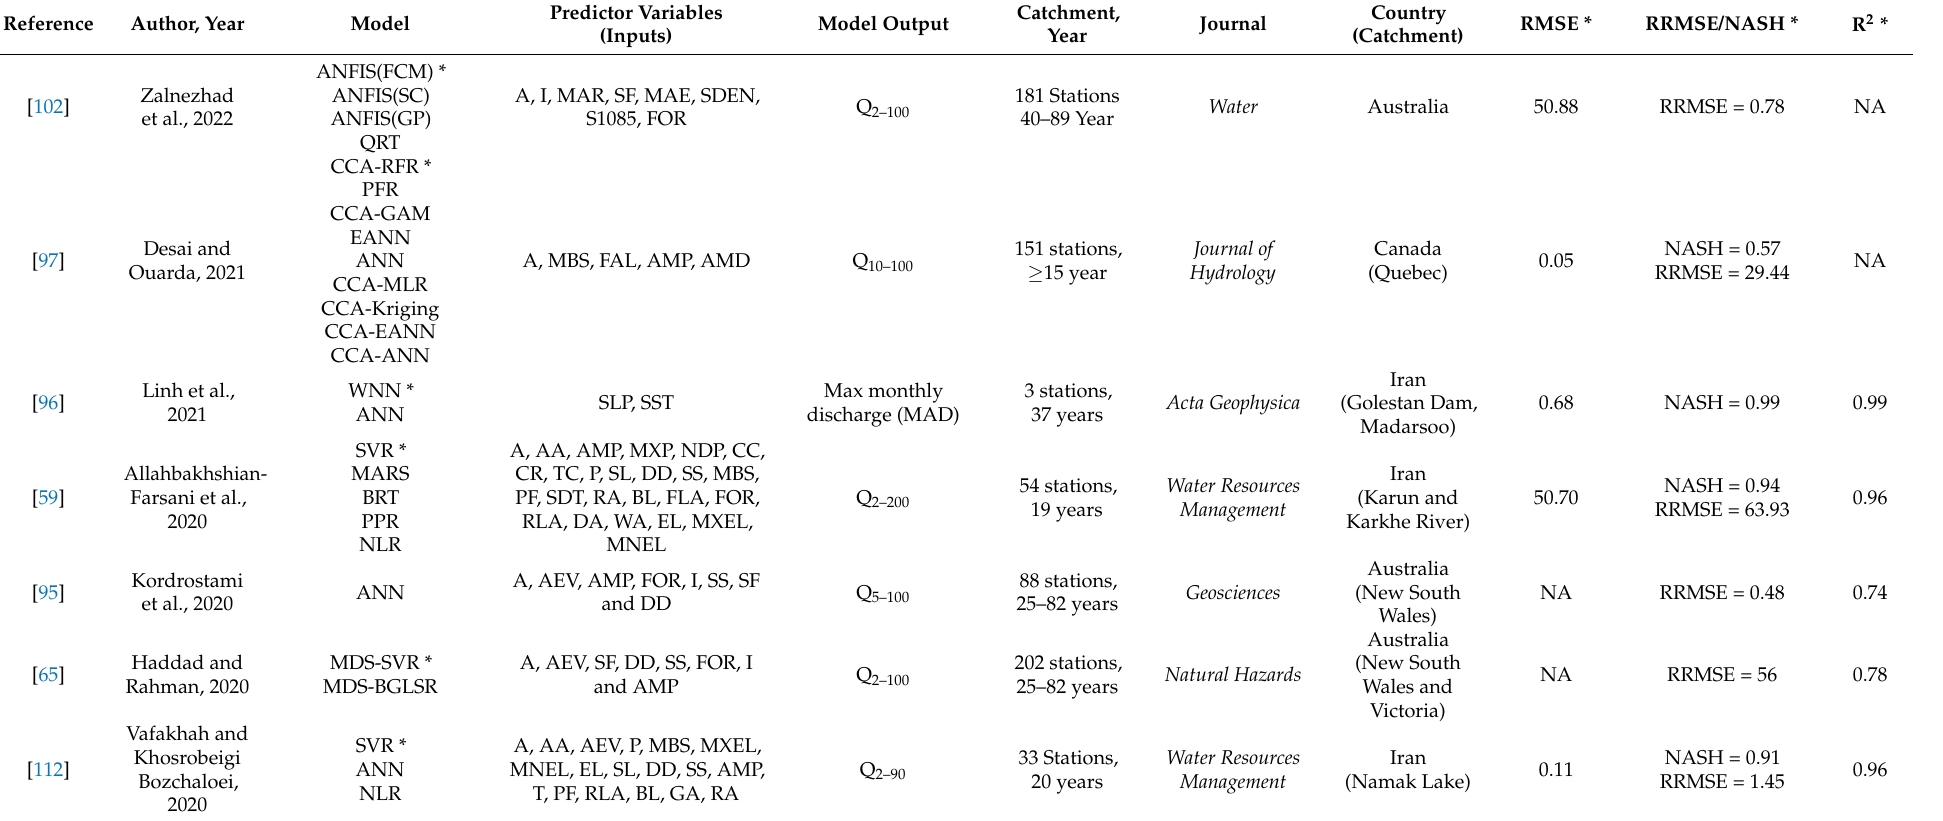
Table 1. Summary of AI-based RFFA studies (* indicates the best model) (ANN = Artificial neural network; GA = Genetic algorithm, BGLS-QRT-ROI: Bayesian generalized least squares QRT combined with region of influence approach, BNN = Backpropagation neural network, CANFIS = Co-active neuro fuzzy inference system, GEP = Gene-expression programming, GRNN = generalized regression neural networks, LGP = Linear genetic programming (LGP), LR = Linear regression, M5 = M5 model tree, MLP = Multi-layer perceptrons, MLR = Multiple linear regression, MNLR = Multiple non-linear regression, QRT = Quantile regression technique, RBNN = Radial basis function-based neural networks, G-EANN = generalized ANN-Ensembles, EANN = ANN-Ensembles, GAANN = GA-based ANN, BPANN = Back propagation for ANN, FIS = Fuzzy inference system, CCA = canonical correlation analysis, NLCCA = Non-linear canonical correlation analysis, BGLSR = Bayesian generalised least squares, MDS = multidimensional scaling, MARS = multivariate adaptive regression spline, BRT = boosted regression trees, PPR = projection pursuit regression, WNN = wavelet neural network and RFR = random forest